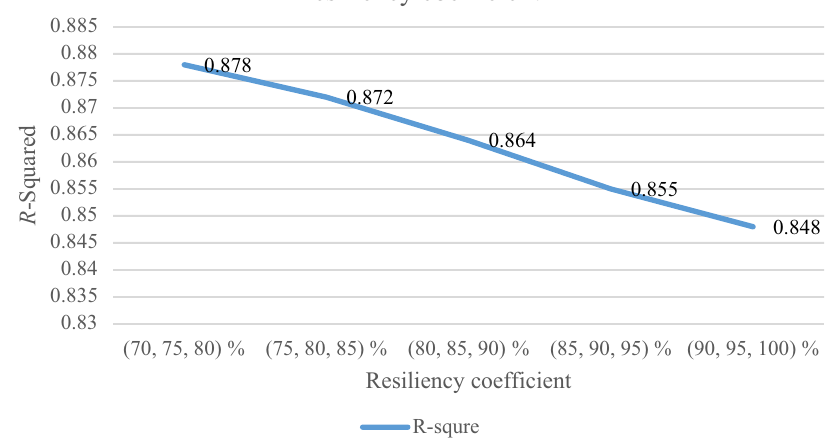
Figure 14. R-squared for resiliency coefficient.